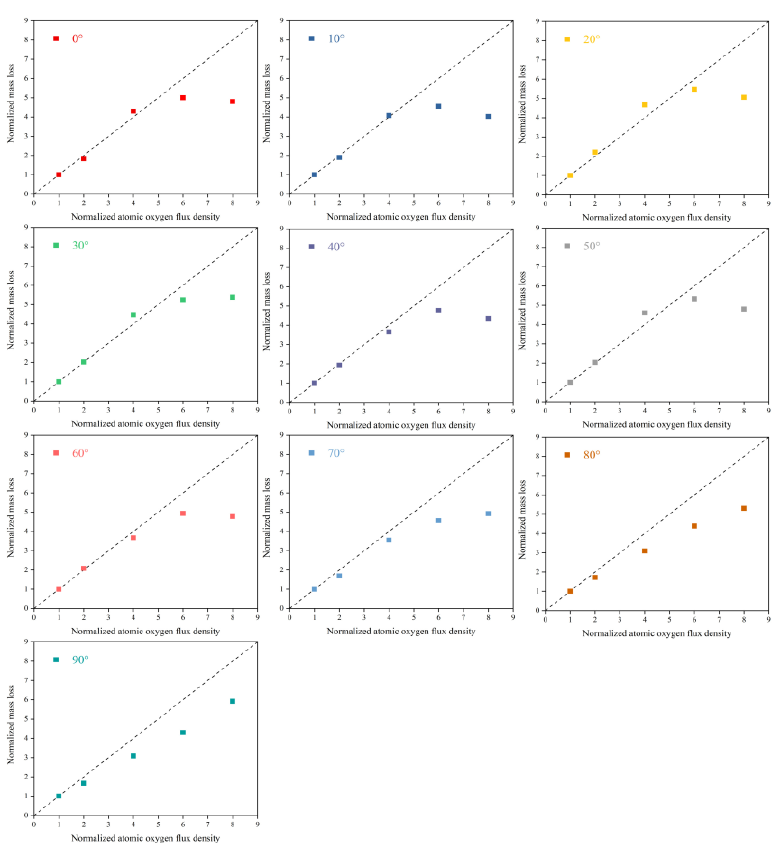
Figure 4. Normalized mass loss of Kapton films versus flux density at different incidence angles.